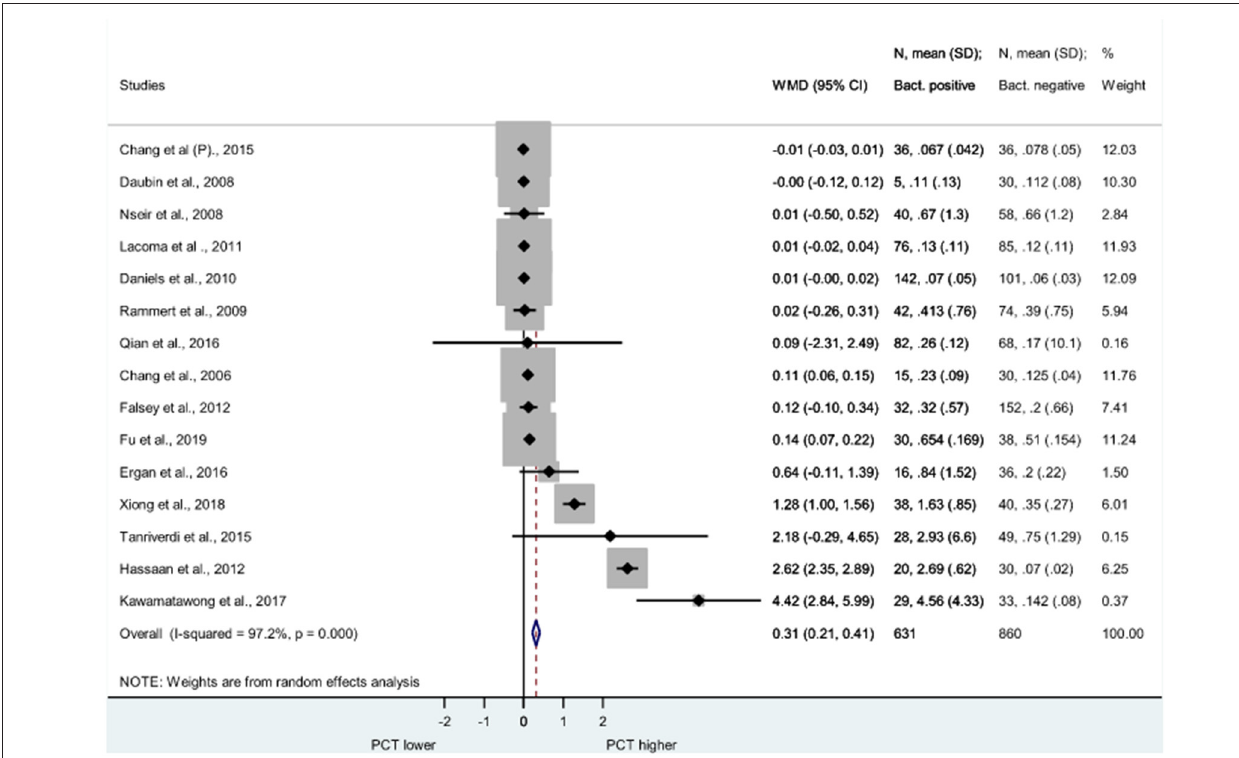
FIGURE 3 | Forest plot of serum procalcitonin. PCT was measured in AECOPD cases with bacteria positive and bacteria negative microbiological cultures. PCT was measured in (ng/ml) in each study. PCT is significantly elevated in bacterial cases than non-bacterial cases. (WMD = 0.31, 95% CI: 0.21–0.41, p < 0.001). AECOPD, acute exacerbation of chronic obstructive pulmonary disease; PCT, procalcitonin; SD, standard deviation; WMD, weighted mean difference; CI, confidence